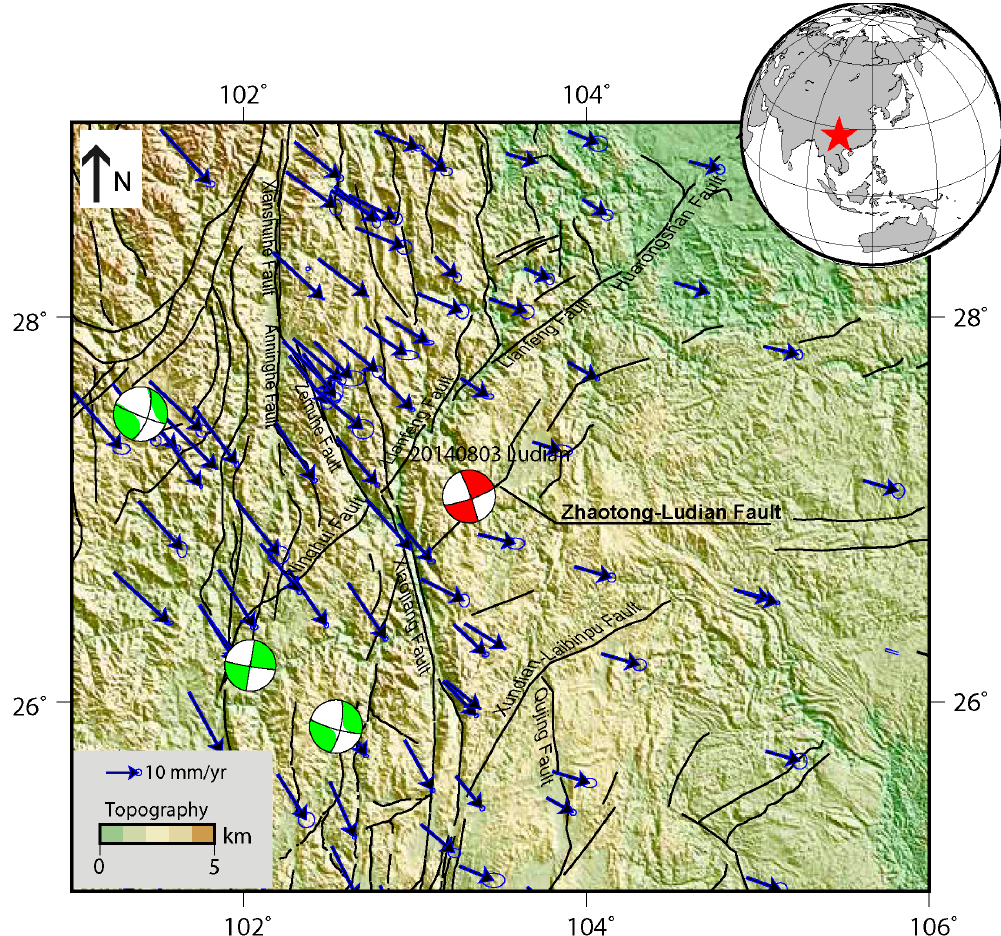
Figure 1. Tectonic setting of the study area. The red beach ball is the GCMT solution for the 2014 Ludian earthquake, and the green balls mark the locations of the Mw ≥ 6 historical earthquakes. The black lines are the regional active faults. The blue arrows are the crustal deformation from Zheng et al. [16].